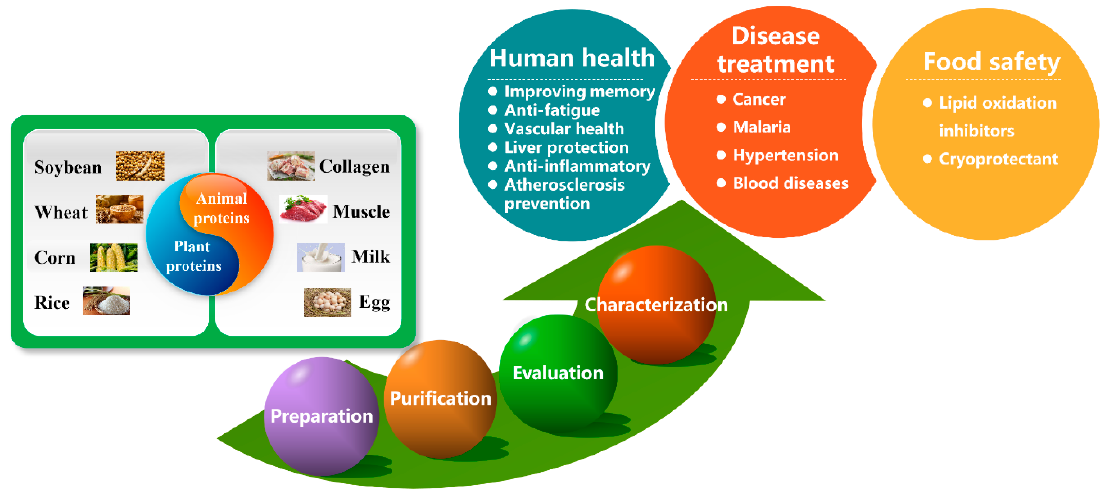
Figure 1. Protein sources, research methods and potential applications of peptidic antioxidants.